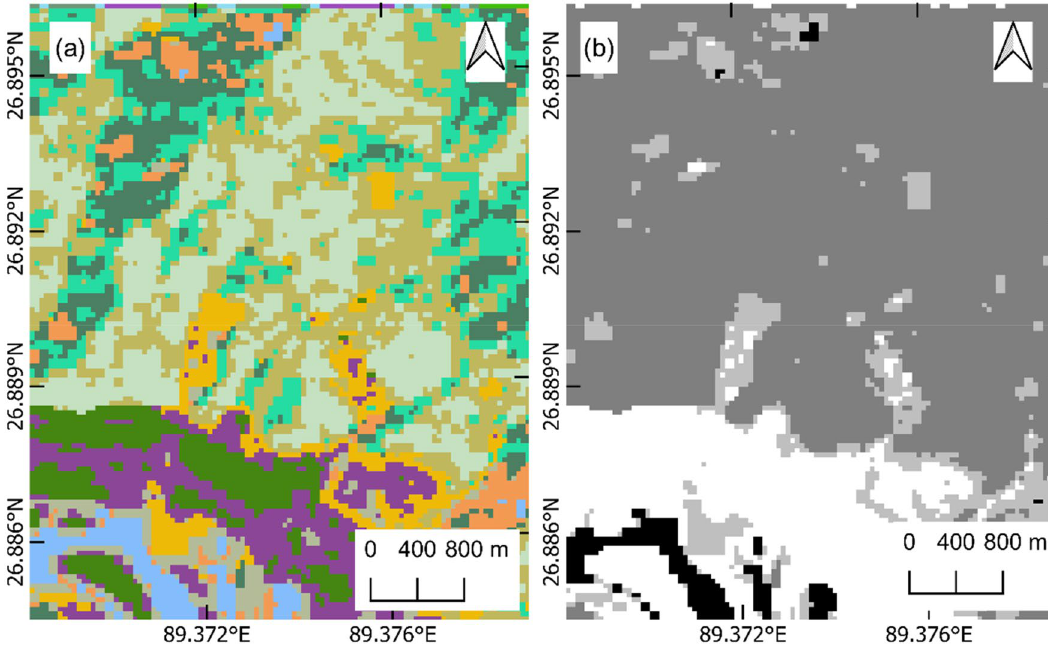
Fig. 5 Prepossessing of Sentinel-2 band sets in SCP: a Clustered pixels, b Reclassified